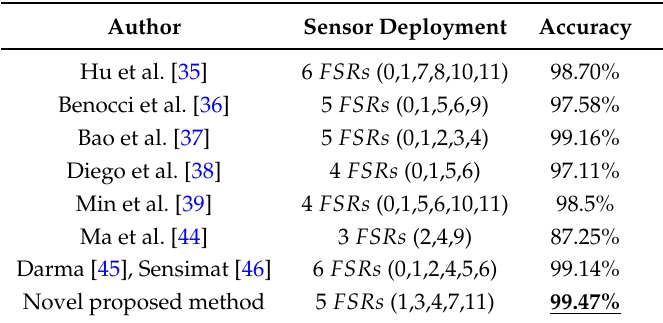
Table 11. Recognition results of different sensor